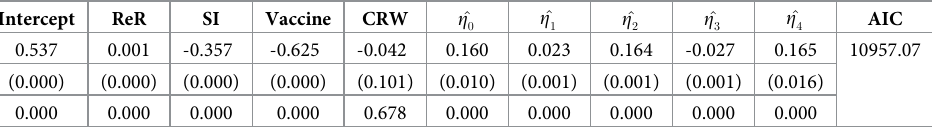
Table 4. Estimates, corresponding standard errors in parentheses and p-values for death series under